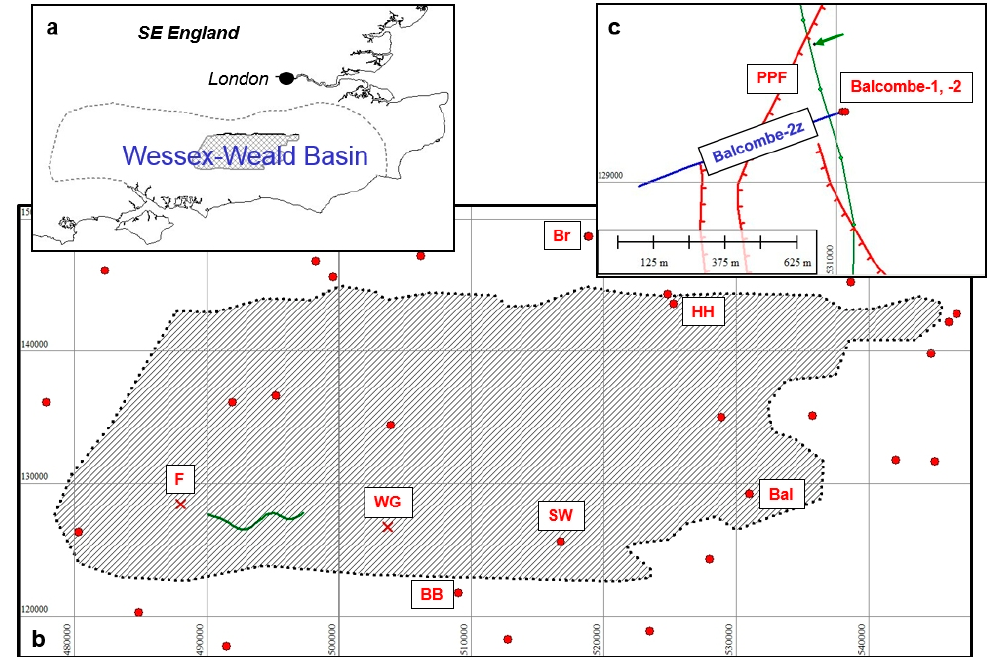
Figure 3. ( a ) Location map of the Wessex–Weald basin. ( b ) Weald Basin with area of mature Kimmeridge Clay Formation shown by hatching. Wells referred to in the text are labelled: Br—Brockham; HH—Horse Hill; SW—Southwater; Bal—Balcombe; BB–Broadford Bridge. Crosses are proposed well locations: F—Fernhurst; WG—Wisborough Green. Wavy green line—2D seismic line pictured by Celtique Energie. ( c ) The Balcombe locality: mapped surface normal faults are shown by red lines with teeth on the downthrown side (PPF—Paddockhurst Park Fault). Blue line—subsurface location of horizontal well Balcombe-2z. Green line—2D seismic line used in planning application by Cuadrilla. Green arrow—location of Balcombe-1 as mispositioned by